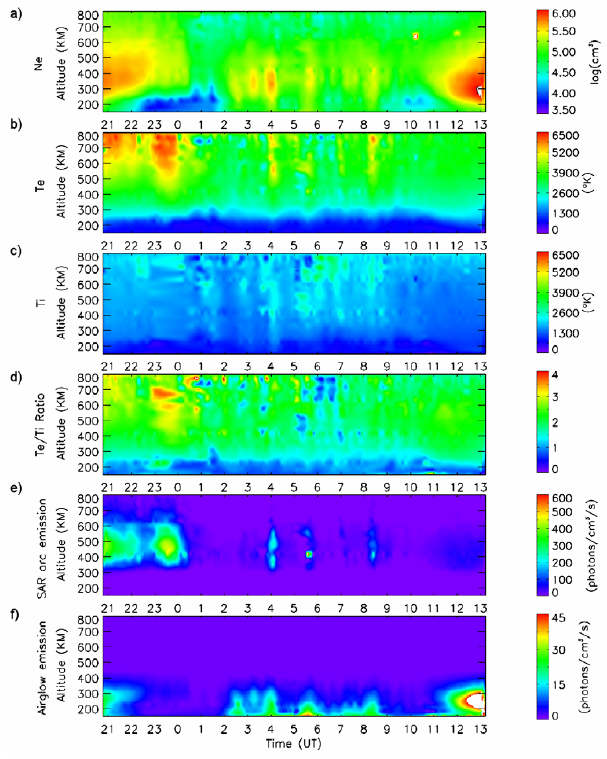
Fig. 7. Time history of ionospheric parameters versus height made Figure 7. Time history of ionospheric parameters versus height made at Millstone Hill at times during the night of 28-29 October 1991 when the ISR pointed in at Millstone Hill at times during the night of 28–29 October 1991 the vertical direction: (a) electron density, (b) electron temperature, (c) ion when the ISR pointed in the vertical direction: (a) electron density, temperature, (d) T e /T i ratio. Panel (e) gives the computed SAR arc volume (b) electron temperature, (c) ion temperature, (d) T e / T i ratio. Panel emission rates, and panel (f) the computed airglow volume emission rates. (e) gives the computed SAR arc volume emission rates, and panel The total modeled SAR arc brightness over this altitude region comes to 10,840 R at 00:38 UT, while the integrated airglow value is 81 R. (f) the computed airglow volume emission rates. The total modeled SAR arc brightness over this altitude region comes to 10840R at 23:32 UT, while the integrated airglow value is 81R.